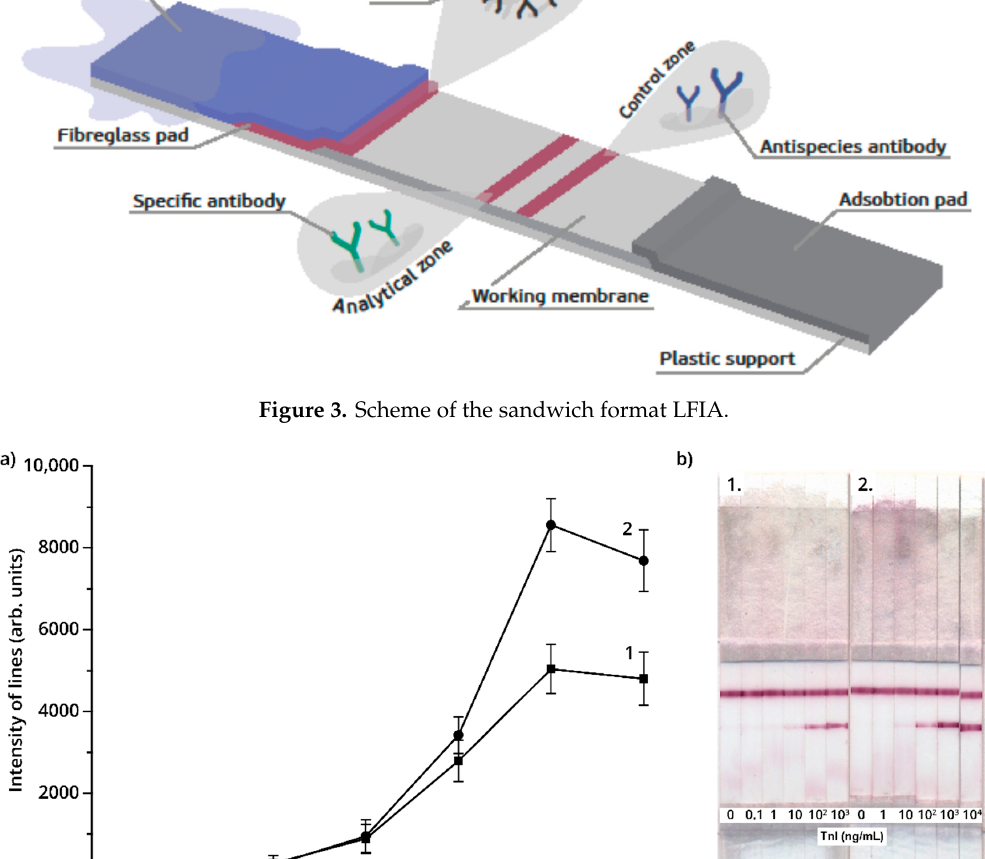
Figure 3. Scheme of the sandwich format LFIA.